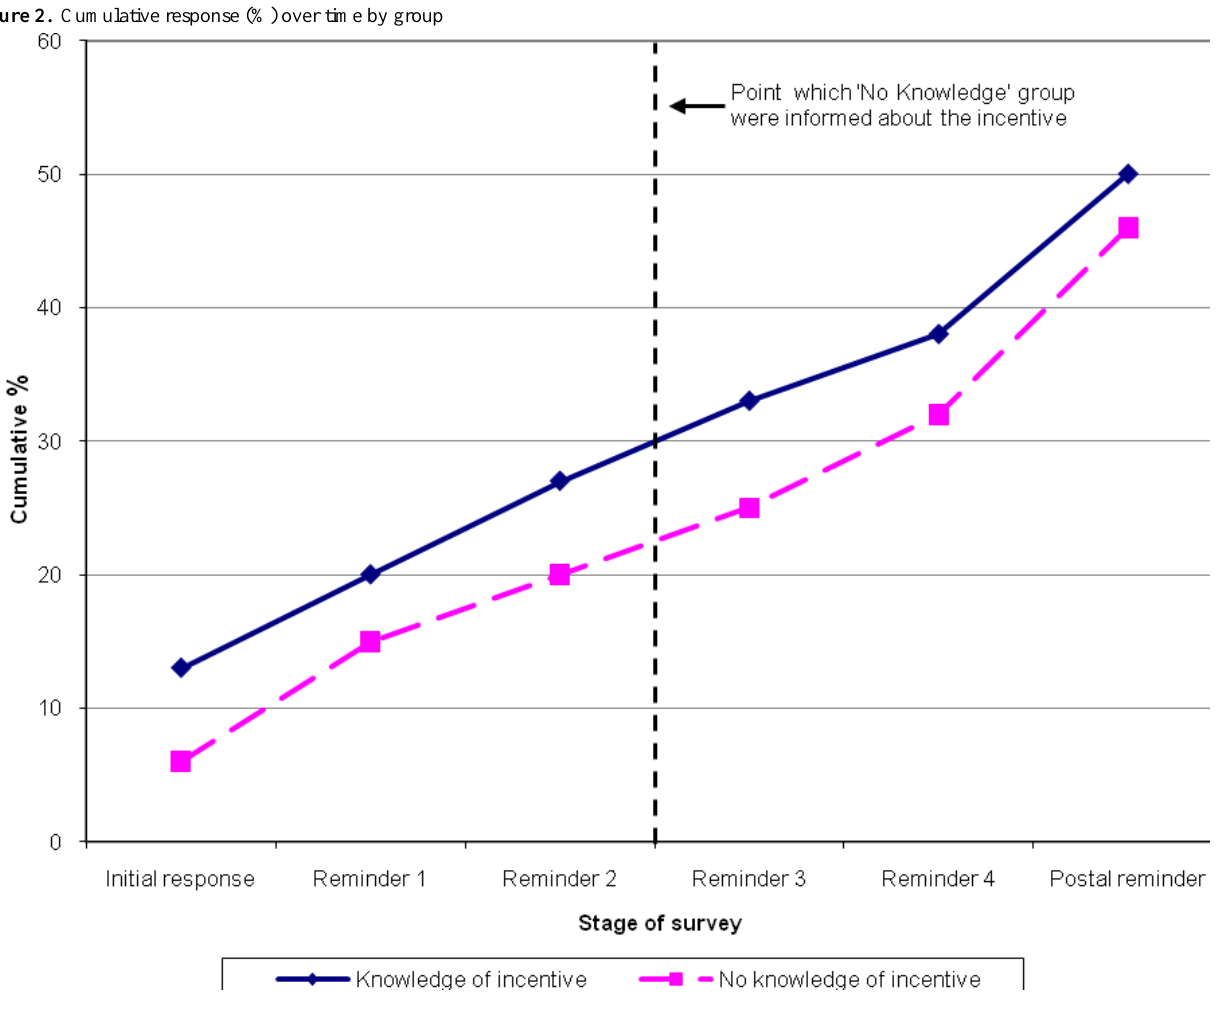
χ 2 SignificanceNo Knowledge Group a (n = 241)Knowledge Group (n = 244)